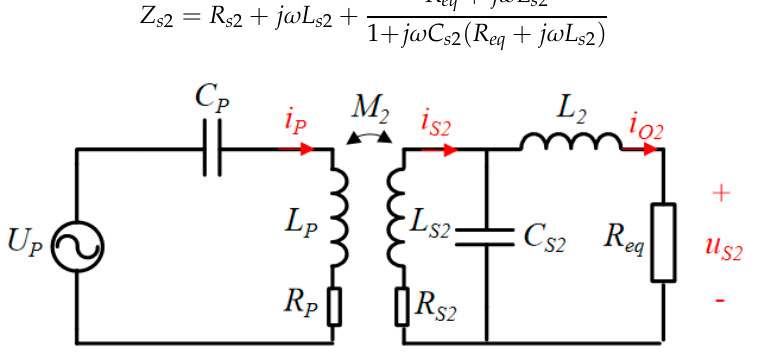
Figure 15. Equivalent S-LCL compensation topology.